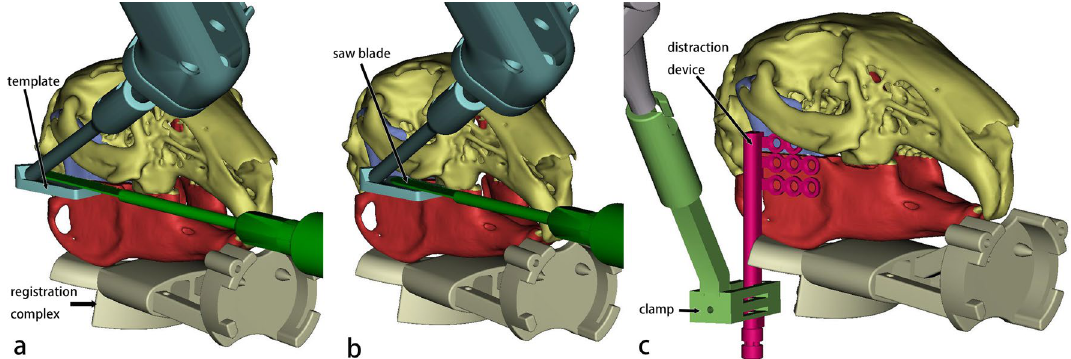
Figure 3. Surgical plan shown in Mimics. ( a ) The template is at the initial position to guide the osteotomy, with the saw blade closely beside it. ( b ) The template is at the second position, and the blade moves forward along it. ( c ) The clamp with the distractor on is in position. Cyan: robotic arm end with the template. Green: reciprocating bone saw. Light gray: registration complex. Light green: self-designed clamp. Pink: distractor. Purple: the proximal mandibular ramus of the osteotomy line. Red: the distal part of